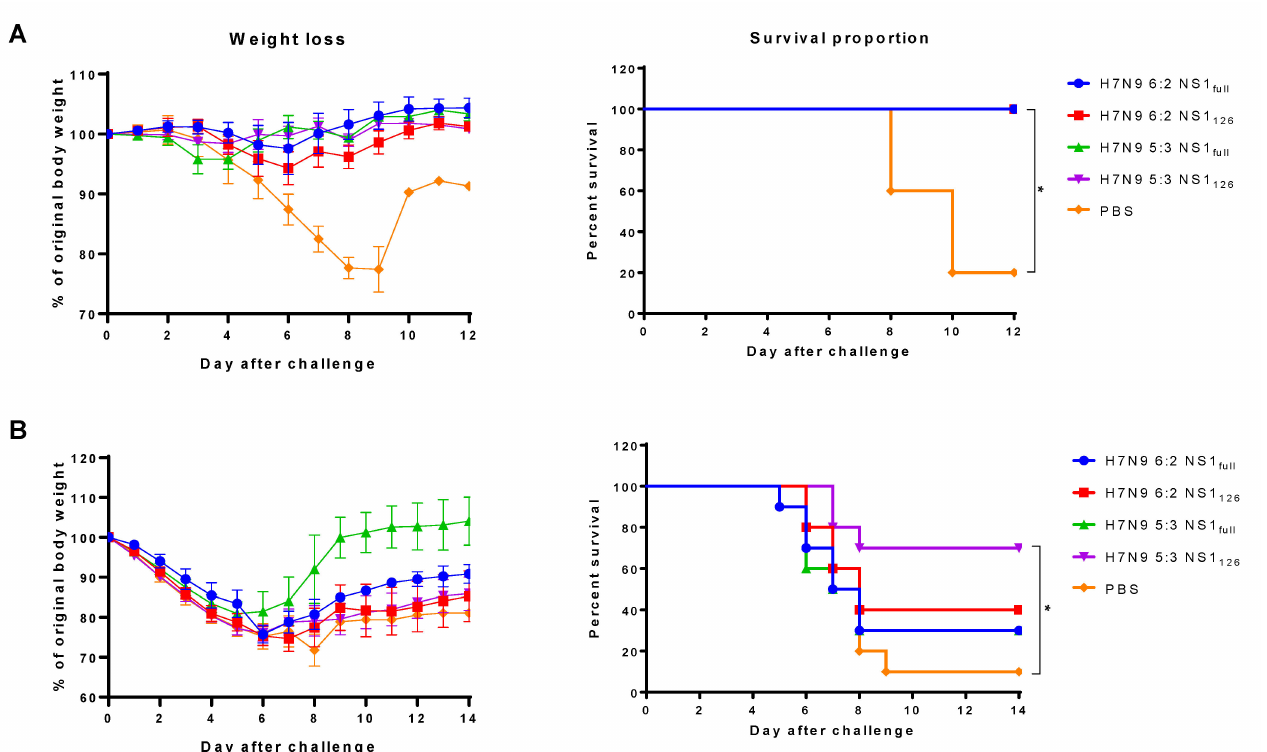
Figure 6. Protection of immunized mice against two different doses of heterosubtypic lethal virus. Mice were immunized with two doses of indicated H7N9 LAIV viruses or PBS and challenged with 10 6 EID 50 ( A ) or 10 7 EID 50 ( B ) of the PR8 7:1 (NP/H7N9) challenge virus. Weight loss (left panel) and survival rates (right panel) were monitored for two weeks post-challenge. Survival rates were compared by Mantel–Cox log-rank test. * p <